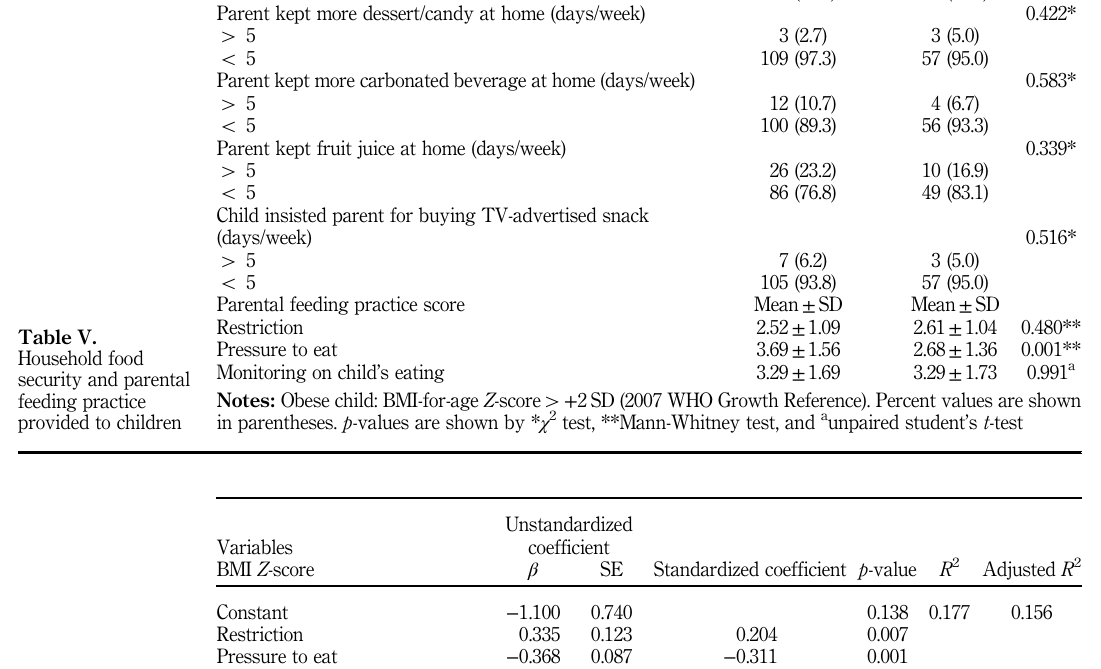
Table VI. Factors associated with child ’ s BMI by multiple linear regressions